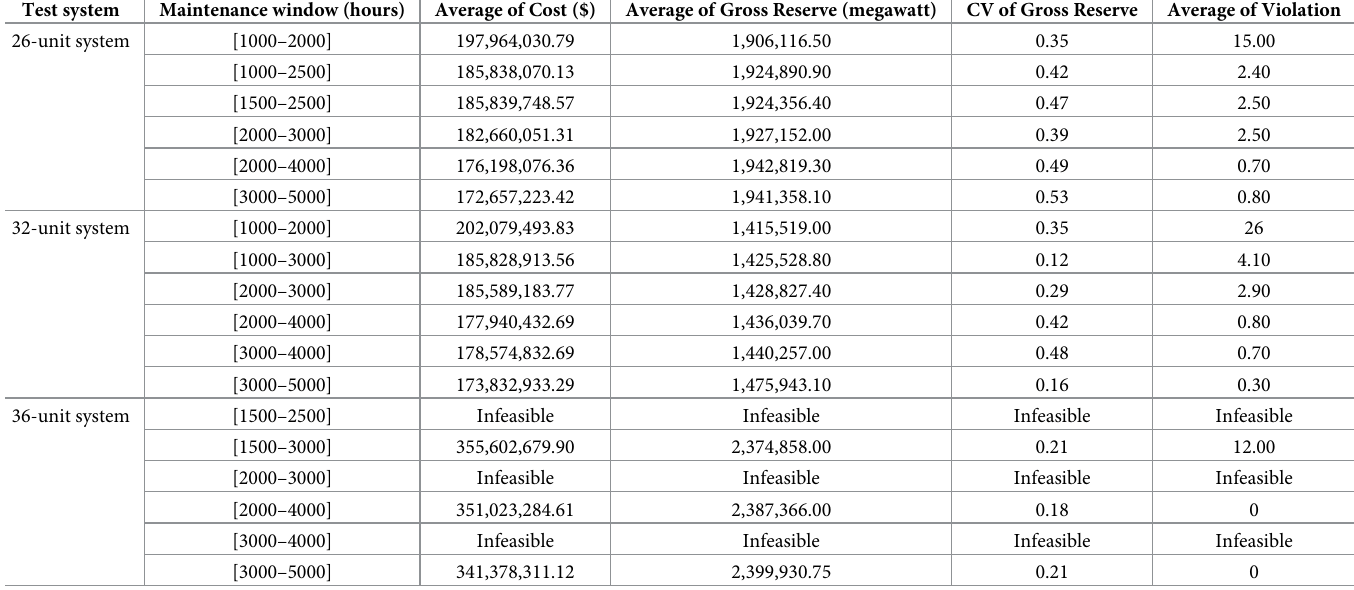
Table 9. Results of GMS model